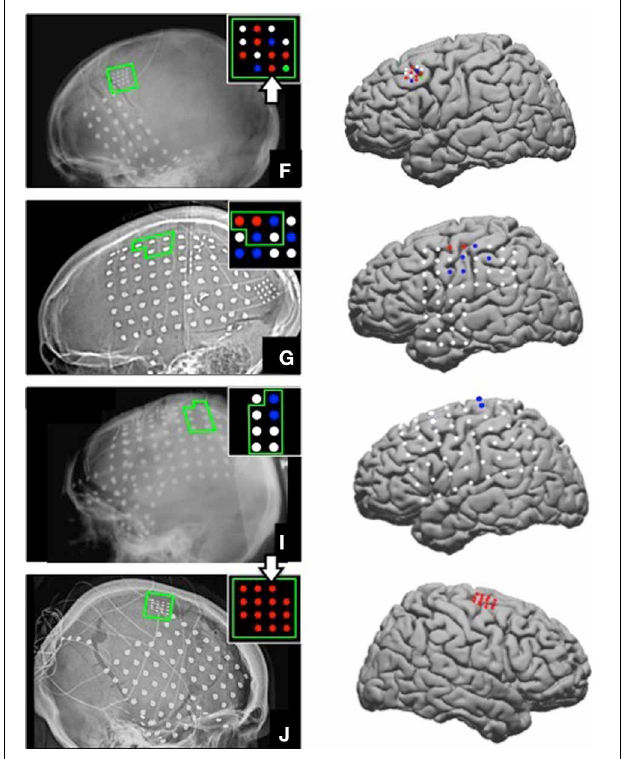
FIGURE 1 | ECoG grid locations. Left, ECoG grid locations shown on x-ray for Subjects F, G, I, and J. The motor cortical areas are highlighted in green. The schematic inset on each x-ray shows electrodes that were significantly modulated as indicated by the color. Red = Significant modulation during action execution (AE) and observation (AO), Blue = Significant modulation during AE only, Green = Significant modulation during AO only, White = no significant modulation. Electrode positions are shown on a standard brain model to the right of each x-ray using the same color scheme. The two large white arrows (Subjects F and J) mark the two electrodes whose data are shown in Figures 3 , 4